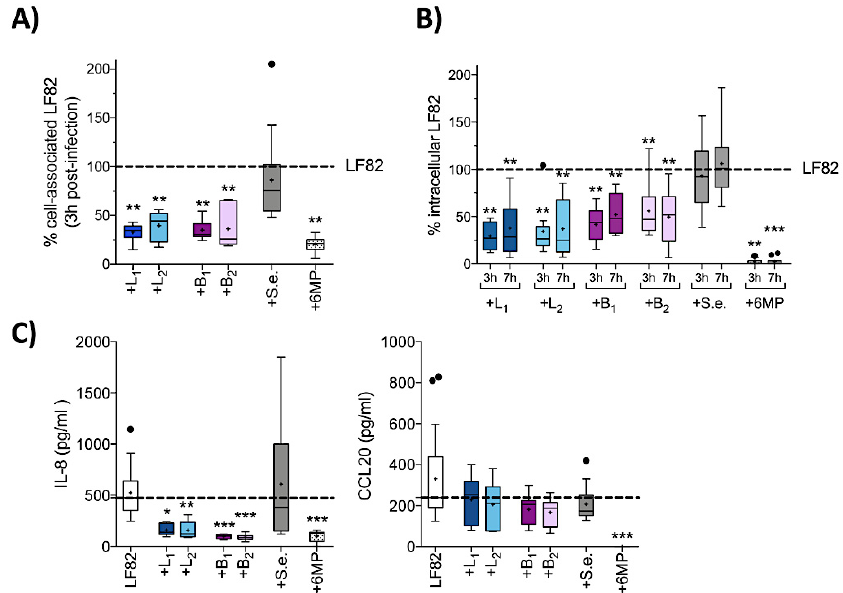
Figure 1. E ff ects of probiotic strains on adhesion and invasion of intestinal epithelial cells (IECs) by AIEC-LF82 and the relative inflammatory response. ( A ) Adhesion to HT29 cell monolayers of AIEC-LF82 alone (taken as 100%) or in the presence of Lactobacillus acidophilus LA1 ( + L 1 ), Lactobacillus paracasei 101 / 37 ( + L 2 ), Bifidobacterium animalis spp. lactis Bi1 ( + B 1 ), Bifidobacterium breve Bbr8 ( + B 2 ), S. epidermidis ATCC-155 ( + S.e.) at 1:1 ratio or in the presence of 6-mercaptopurine ( + 6MP, 2 µ g / mL) was quantified after a 3 h incubation period; ( B ) invasion of AIEC-LF82 alone (taken as 100%) or in the presence of probiotic strains or S. epidermidis ( + S.e.) at 1:1 ratio or in the presence of 6MP was quantified after a 3 h or 7 h incubation period. Results are expressed as the percentage of cell-associated LF82 (adherent plus intracellular LF82 cells) or intracellular LF82 relative to those obtained in monoinfection with LF82 alone, taken as 100%; ( C ) IL-8 and CCL20 secretion by HT29 cells after 7 h of infection with AIEC-LF82 alone or in the presence of probiotic strains or S. epidermidis ( + S.e.) at 1:1 ratio or in the presence of 6MP was quantified by ELISA. Dot lines (—) represent the median values for cytokine secretion of HT29 cells infected with LF82 alone. Each experiment was performed in triplicate, and data are represented with box-plots showing the median, range and upper and lower quartiles of at least three independent experiments. Means are represented as black cross ( + ), median as horizontal lines, and outliers are marked as dots. Statistical significance for each condition compared to HT29 infected with LF82 alone was reported (* p < 0.05, ** p < 0.01, *** p <